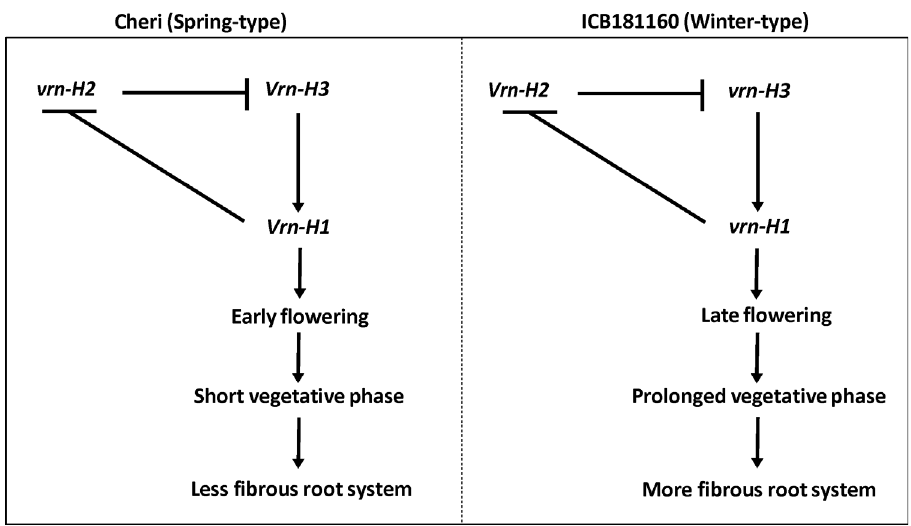
Fig 5. Proposed genetic model suggesting and interplay of heading and root-shoot traits in